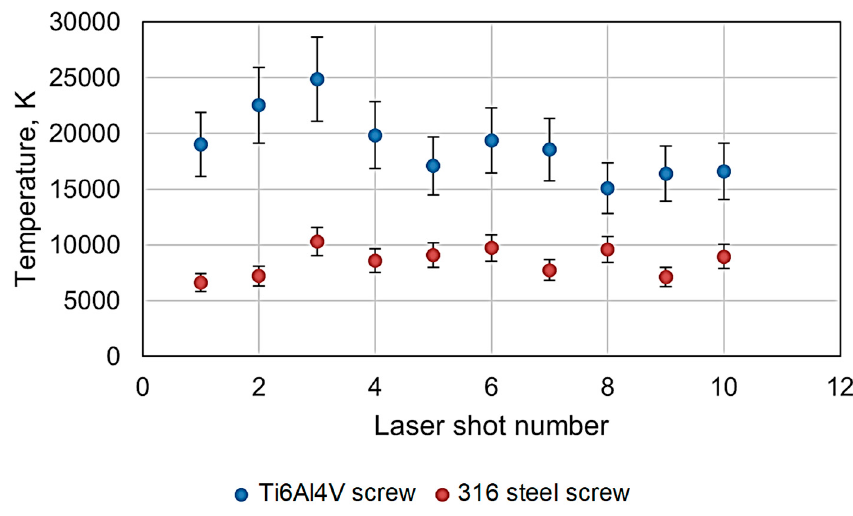
Figure 9. Plasma temperatures for subsequent shots in the stratigraphy experiment.